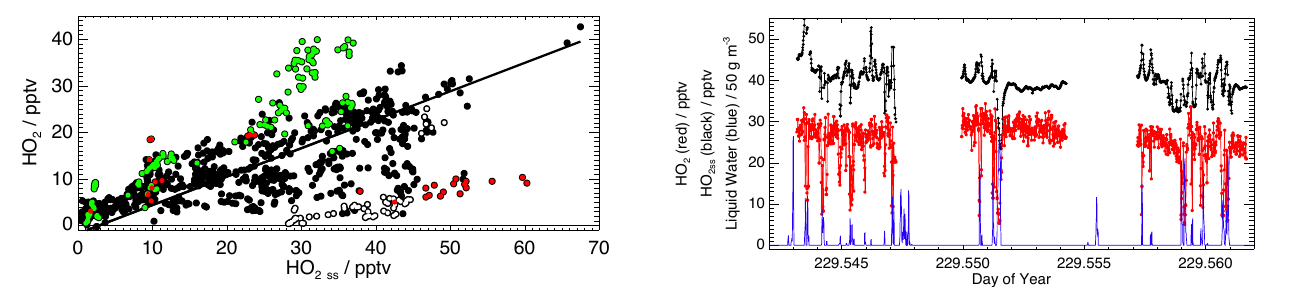
Fig. 15. Time Series of HO 2 variation in Cloud. HO 2 (1s, pptv, red), HO 2 ss (1s, pptv, black), scaled Nevzorov probe liquid wa- ter content (gm − 3 × 50) (blue). Data were taken between 13:00 and 13:30UTC at a constant altitude of 1.5km over northern Benin (10.9 ◦ –12.5 ◦